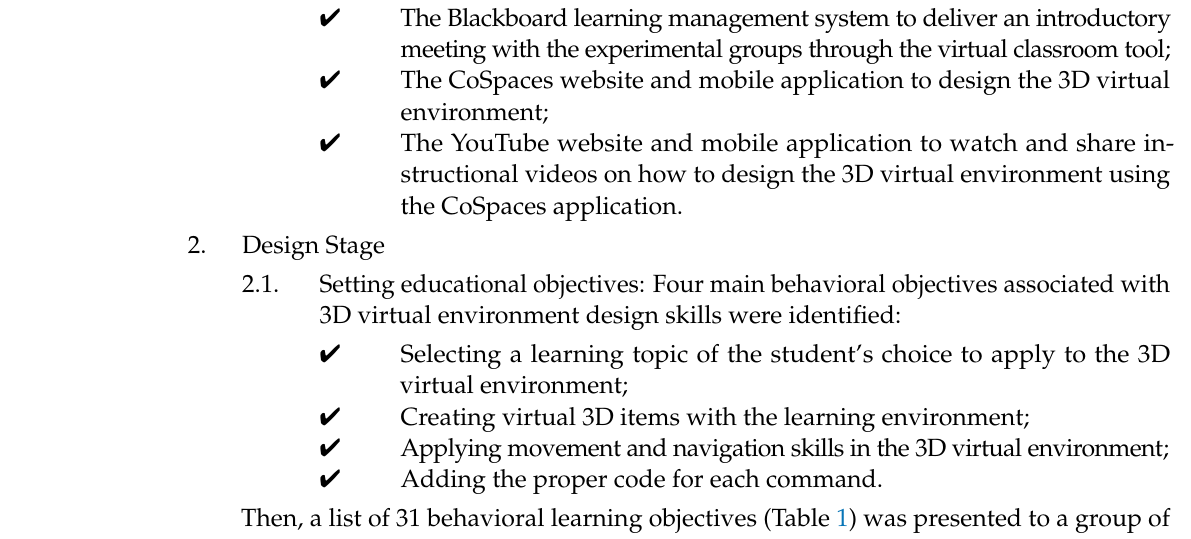
No Skills Selecting a learning topic of the student